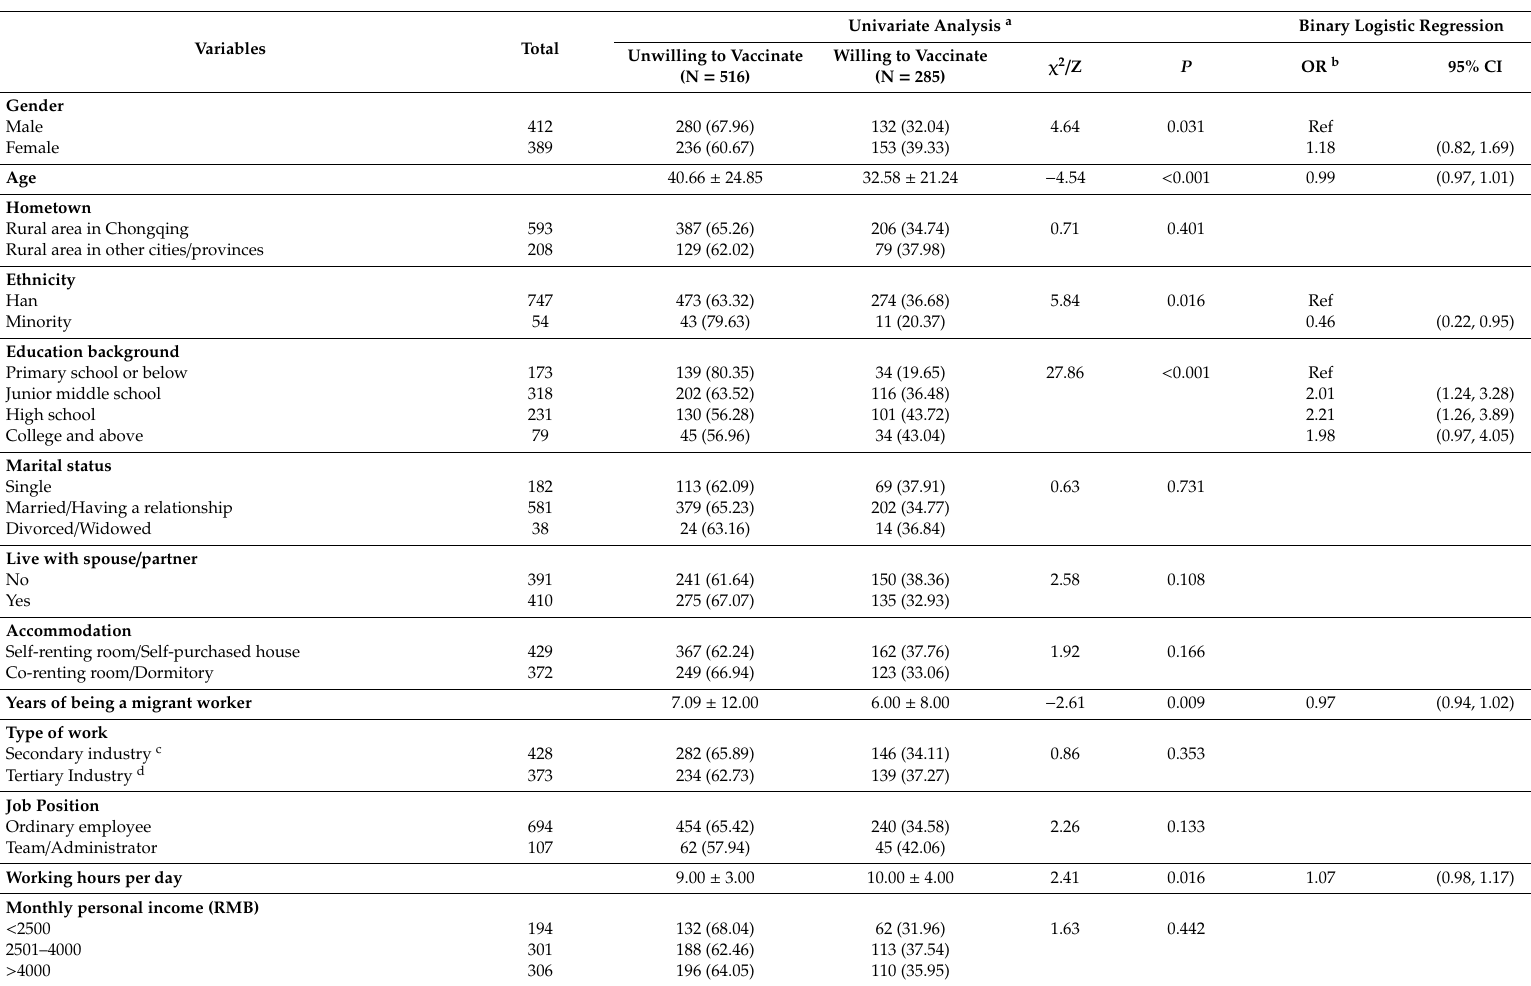
Univariate Analysis a Binary Logistic Regression Unwilling to Vaccinate Willing to Vaccinate χ 2 / Z OR b (N = 516) (N = 285)